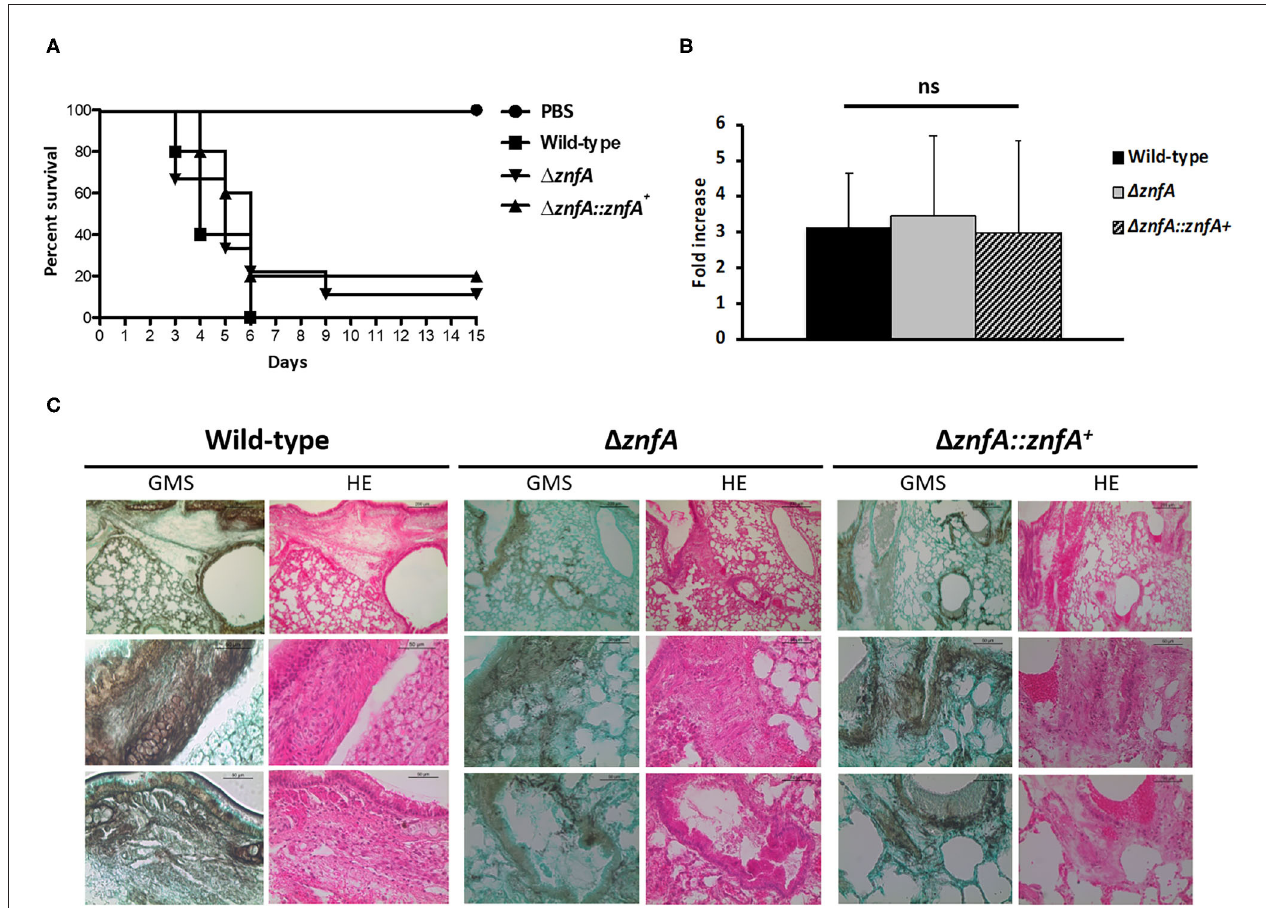
FIGURE 6 | A. fumigatus ZnfA is not required for virulence in a chemotherapeutic murine model of invasive pulmonary aspergillosis. (A) Comparative survival analysis of Wild-type, 1 znfA , and 1 znfA :: znfA + strains in a chemotherapeutic murine model of invasive pulmonary aspergillosis. Mice in groups of 10 per strain were inoculated intranasally with a 20 µ l suspension of conidia at a dose of 10 5 . PBS, Phosphate Buffer Saline. The statistical significance of comparative survival values was calculated by Prism statistical analysis package by using Log-rank (Mantel-Cox) Test and Gehan-Brestow-Wilcoxon tests. (B) Fungal burden was determined 48h post-infection by real-time qPCR based on the 18S rRNA gene of A. fumigatus and an intronic region of the mouse GAPDH gene. Fungal and mouse DNA quantities were obtained from the Ct values from an appropriate standard curve. Fungal burden was determined through the ratio between ng of fungal DNA and mg of mouse DNA. The results are the means ( ± SD) of five lungs for each treatment. Statistical analysis was performed by using one-tailed, paired t -test (ns, not significant). (C) Histopathology of mice infected with A. fumigatus wild-type, 1 znfA or 1 znfA :: znfA + mutant strains. GMS (Grocott’s Methenamine Silver) and HE (Hematoxylin and Eosin) staining of lung sections of representative of infections. The hatched area from the top row is magnified in the lower rows. Bars, 200 and 50 µ